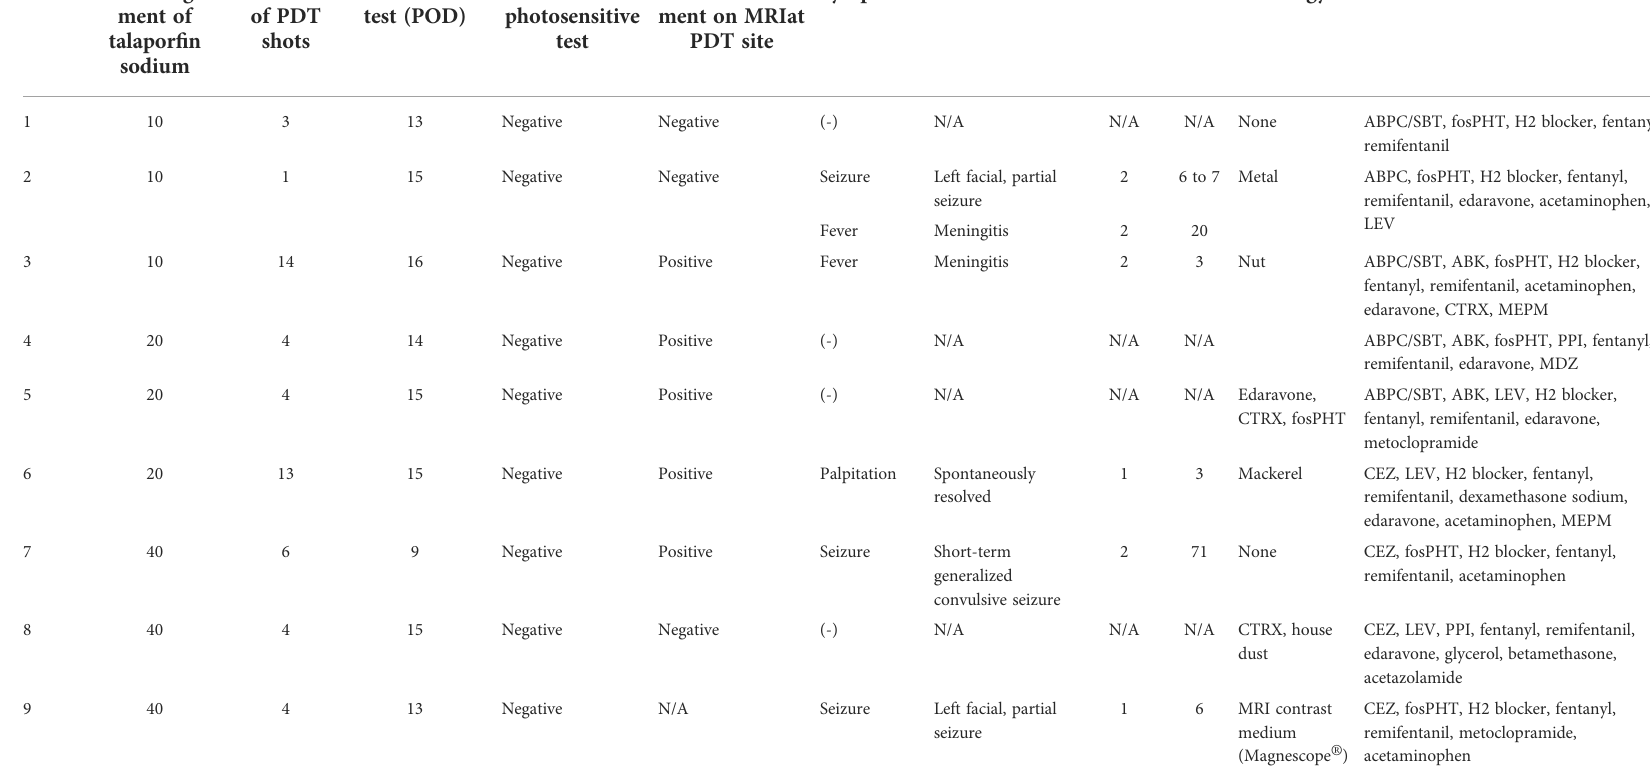
TABLE 3 PDT dose assignment, number of shots, photosensitive test results, and symptoms observed after administration of talapor fi n sodium.